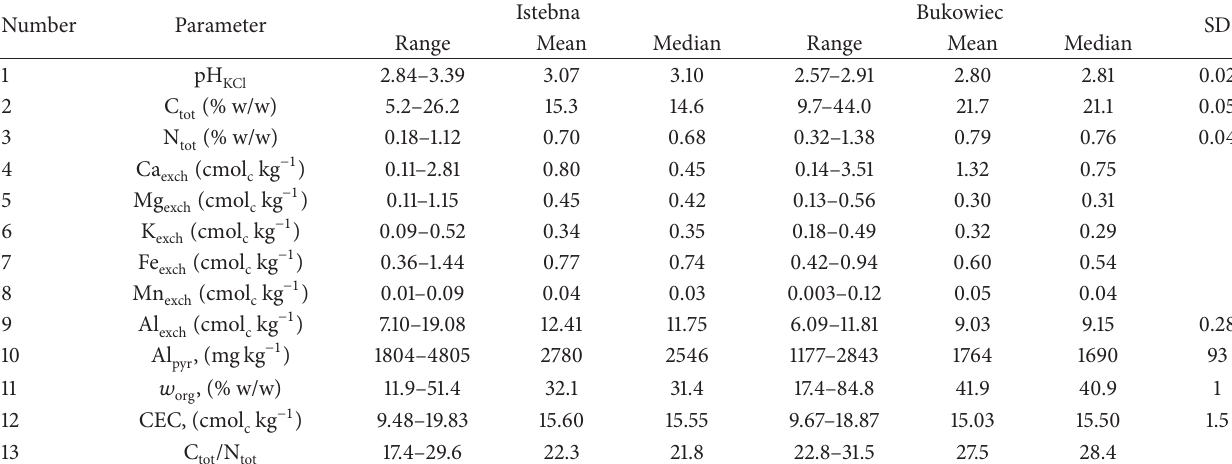
Table 2: Range, average, and median of parameters measured in soil of Silesian Beskid.